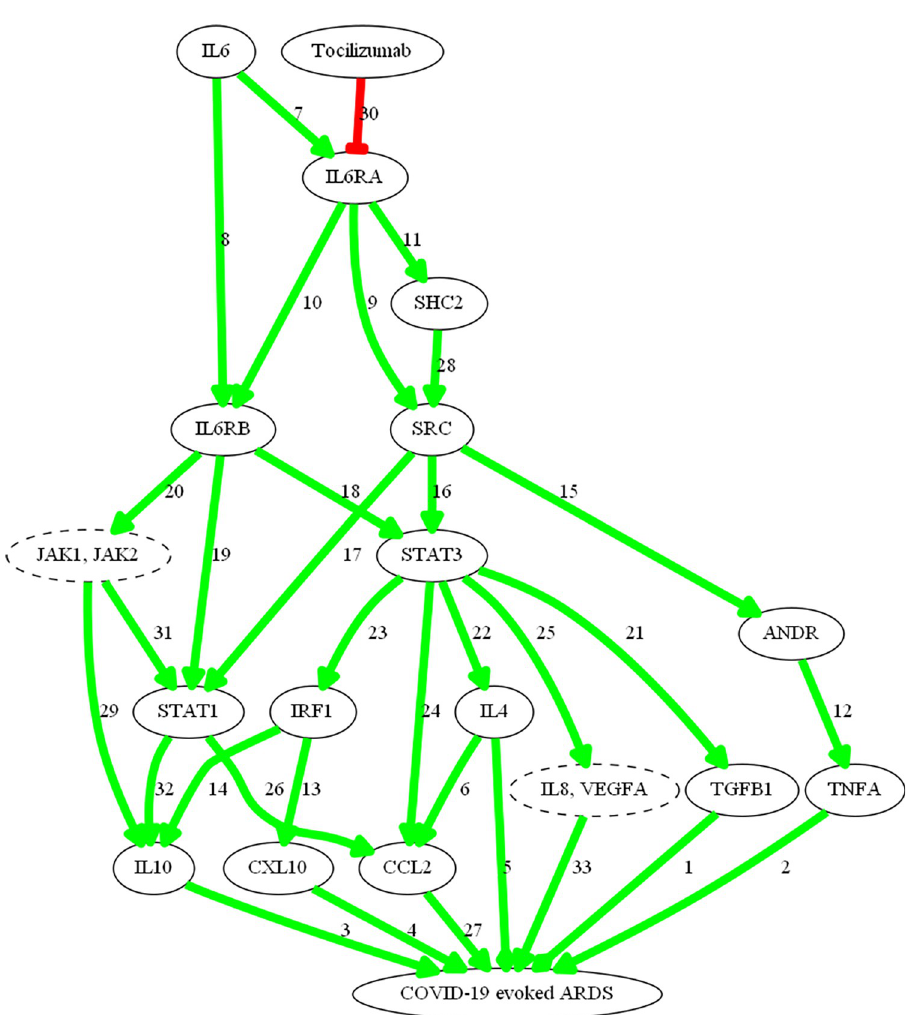
Fig 4. Mechanism of action of tocilizumab. Figure created to represent TPMS MoA predictions using Graphviz software. All links have been manually reviewed: the number of the links correspond to the reference code (link number) in S6 Table. Green arrows show activation; red line shows inhibition; broken-lined circles indicate a node that contains more than one protein, all acting in the MoA in the same